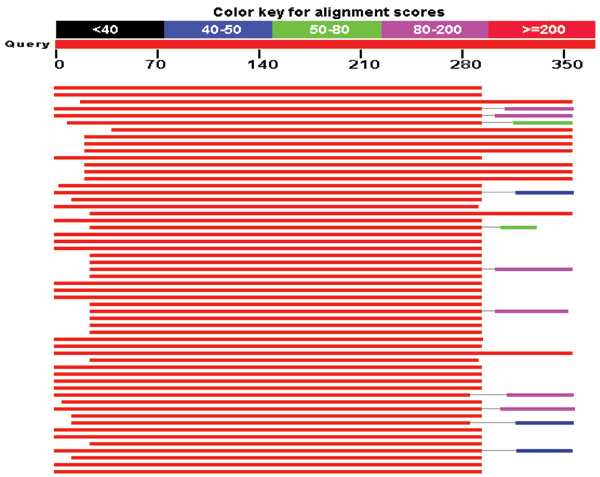
The homology search result provided by NCBI.